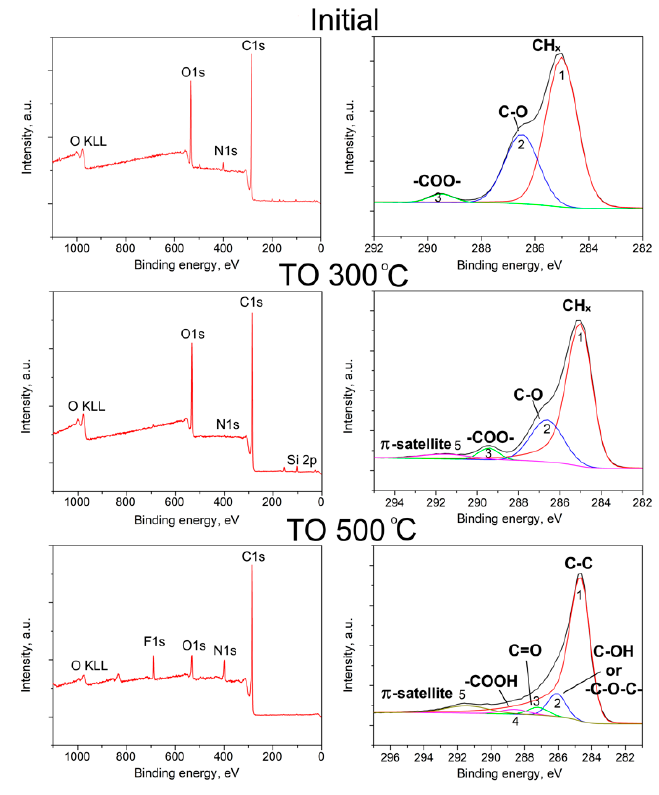
Figure 4. X-ray photoelectron spectroscopy survey spectra ( left ) and the high resolution spectra of C1s ( right ) of the initial and modified (TO 300 °C and TO 500 °C) carbon fibers. Table 1. Concentration of different elements in atomic percent obtained from the x-ray photoelectron spectroscopy results for the carbon fiberssurface before and after thermal oxidation (TO).